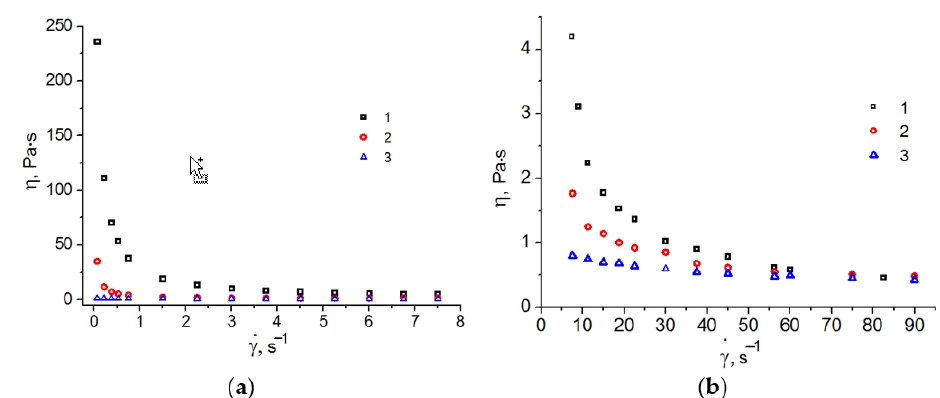
Figure 4. Viscosity curves at low ( a ) and high ( b ) shear rates of the following systems: 1. Chit/LA 15/85 wt. %, 2. C 12 EO 4/ (Chit:LA) 50/50 wt. %, 3. Chit/LA 5/95 wt. %.